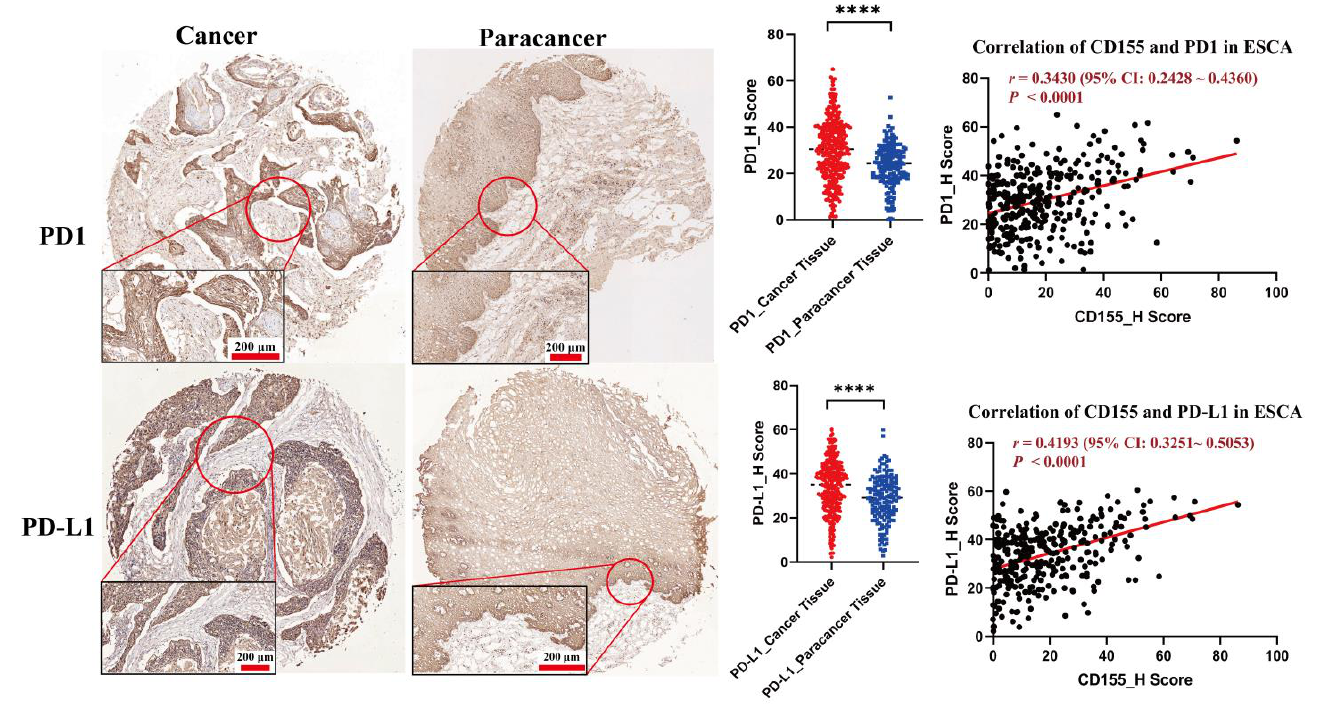
Figure 5. [CD155 is positively associated with PD1/PD-L1]. The correlation analysis between CD155 and PD1 or PD-L1 was performed, and CD155 was positively associated with PD1 ( r = 0.343, p < 0.0001) and PD-L1 ( r = 0.4193, p < 0.0001). A total of 322 ESCA samples was divided into 8 categories based on the expression type of CD155, PD1, and PD-L1; triple positive samples accounted for 58.1%, and double positive samples, PD1 + CD155 + , or PD-L1 + CD155 + accounted for 10.9%. **** p < 0.0001.